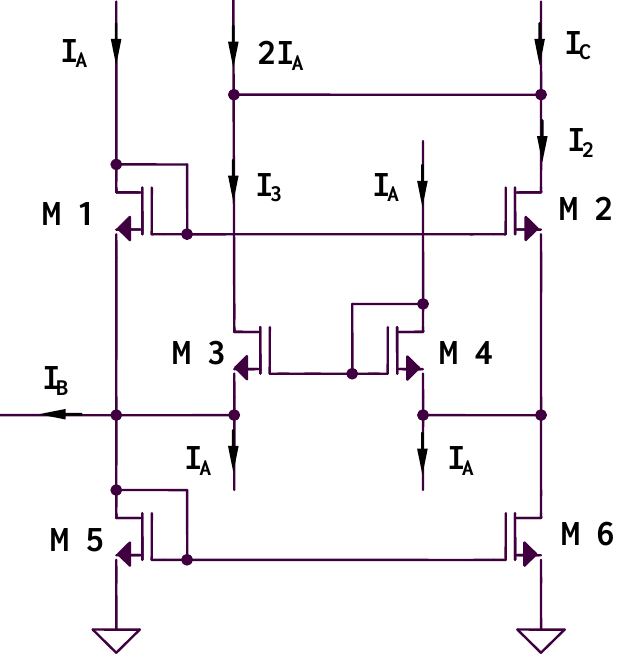
Figure 2. The squaring circuit (SQ).